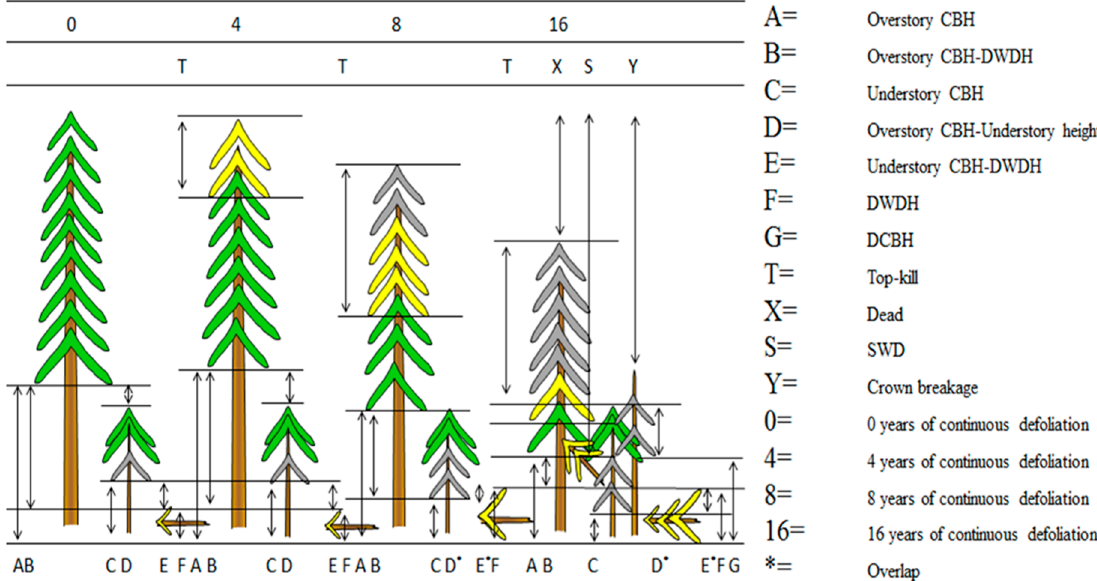
Figure 1. Schematic representation of vertical forest characteristics in boreal forest defoliated by spruce budworm. Represented are host overstory and understory crown base height (CBH), host understory height, top-kill, crown breakage, dead crown base height (DCBH), downed woody debris height (DWDH), suspended woody debris (SWD) and related vertical spacing. Note: The length of top-kill (T) was not measured in this study.